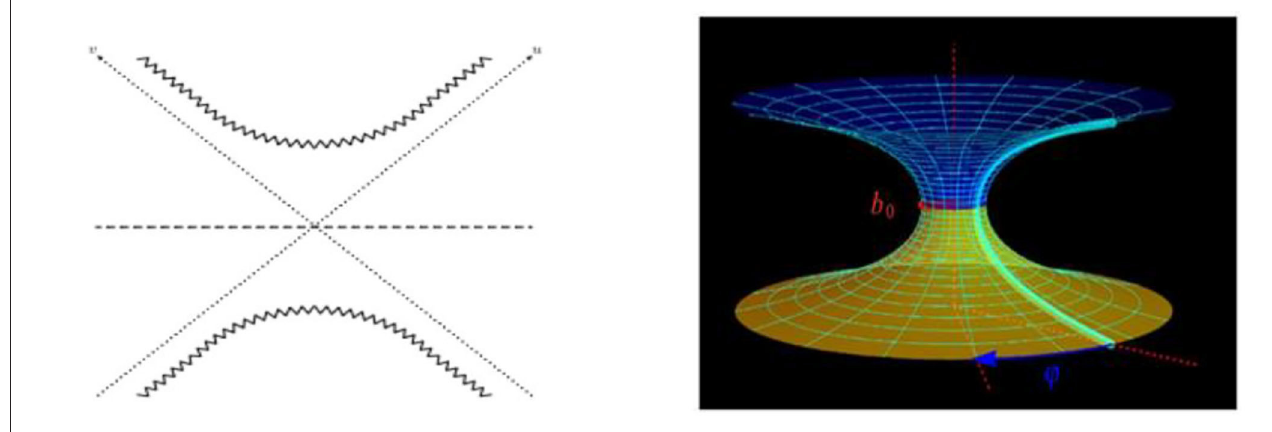
FIGURE 1 | Wormhole hyperboloids. (Left) Lorentzian continuation of the Euclidean cigar. (Right) Schwarzschild